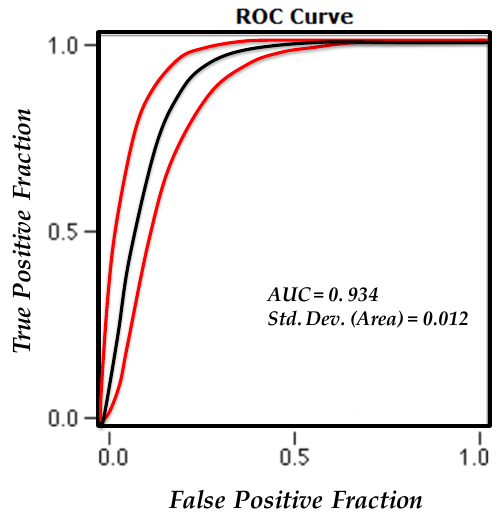
Figure 6. The receiver operating characteristics area under the curve for the proposed LSM. Table 4. Accuracy metrics of implemented LSMs for Northwest Tasmania. Summary Statistics